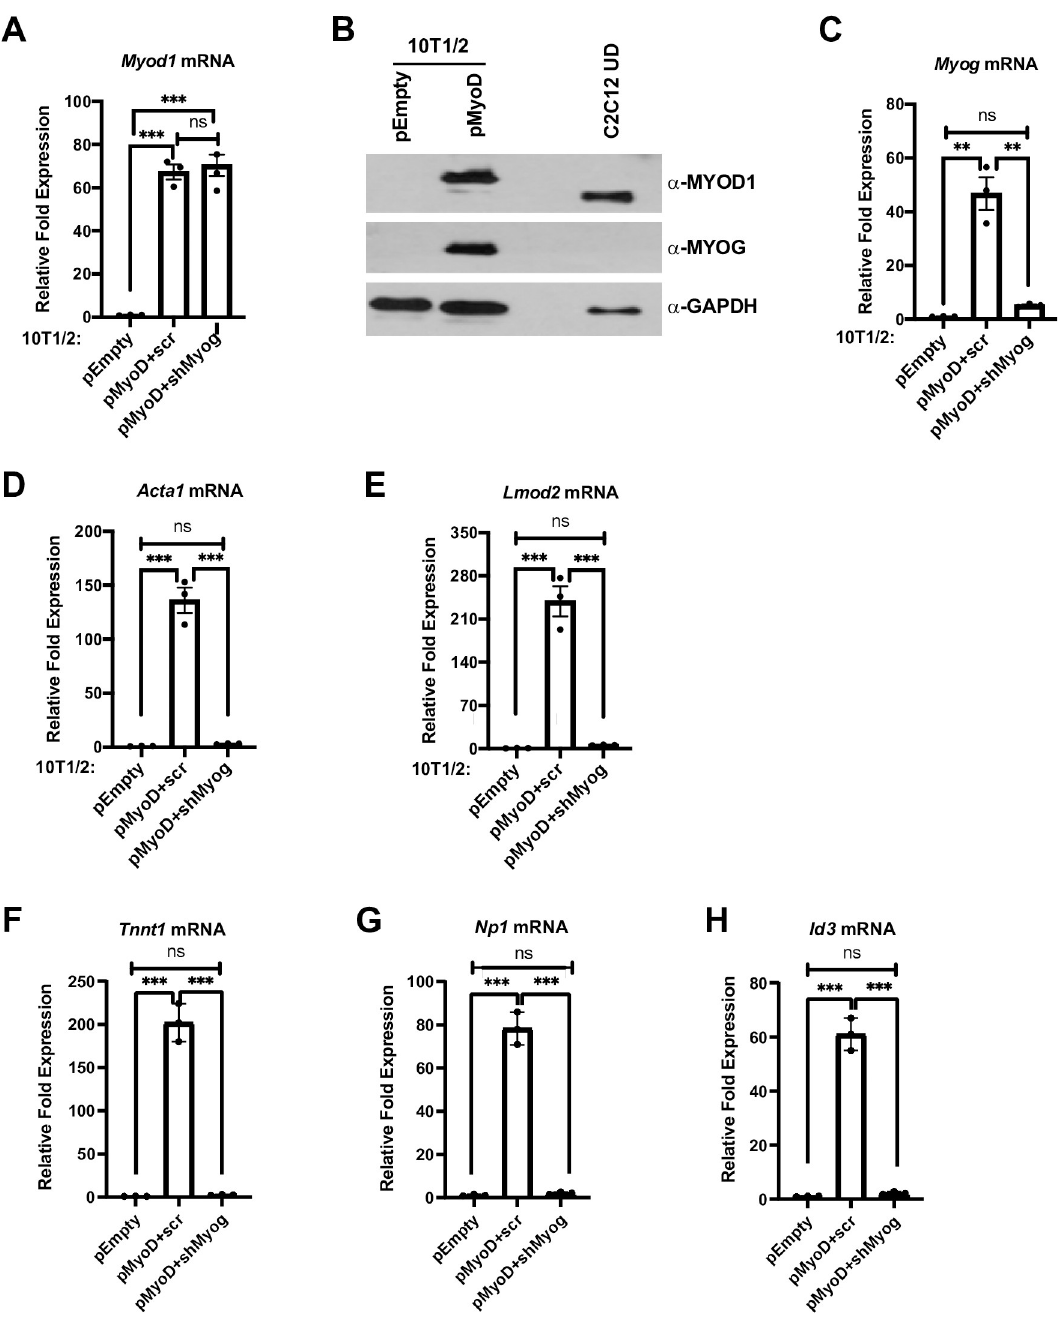
Fig 1. MYOD1 and MYOG are required to induce muscle gene expression in 10T1/2 fibroblast cells. A-H. Plasmid expressing MYOD1 (pMyoD) or empty (pEmpty) vector were stably transfected in 10T1/2 cells. Cells were harvested for mRNA and protein and were analyzed for Myod1 by qRT-PCR (A), and western blot (B), respectively. C2C12 UD was used as a positive control for MYOD1. GAPDH was used as a loading control. Stable cell lines overexpressing Myod1 (pMyoD) were further stably transfected with shRNA constructs targeting Myog (pMyoD+shMyog) or scrambled control (pMyoD+scr). Total RNA was extracted and was assayed for Myod1 (A), Myog (C), Acta1 (D), Lmod2 (E), Tnnt1 (F), Np1 (G) and Id3 (H). Standard errors (S.E.) from the mean (Mean ± S.E.) represents the error bars. (ANOVA test followed by Tukey’s multiple comparison test; ns represents ’not significant’, �� p < 0.01 and ��� p < 0.001, n = 3 biological